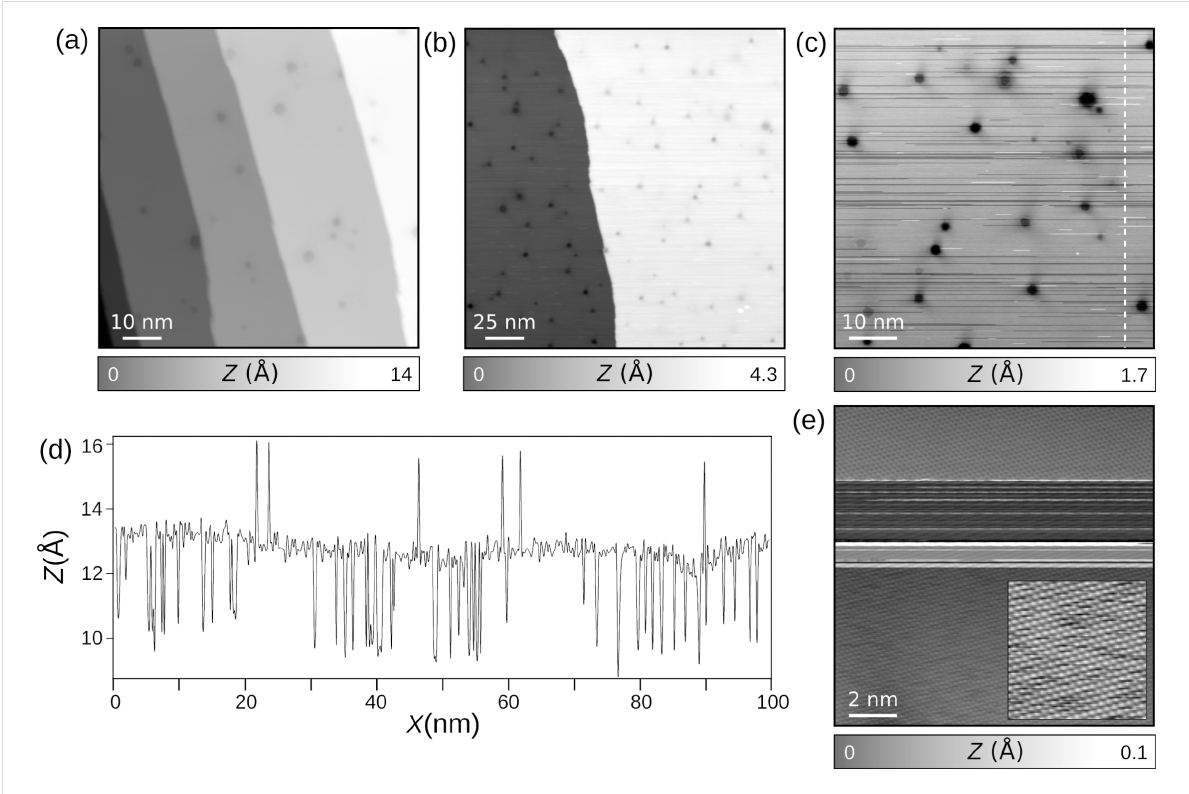
Figure 1: Carbon monoxide (CO) molecules adsorbed on Pb(111). (a) STM overview image of pristine Pb(111) ( V t = − 0.1 V, I t = 1 pA). (b) STM image after CO deposition. The estimated coverage is below 0.2 monolayers. (c) Close-up STM topography of CO molecules diffusing on the surface during scanning ( V t = − 0.1 V, I t = 40 pA). (d) Profile taken along the dashed white line of panel (c) showing spontaneous CO displacement under tip action. (e) Enhanced STM resolution (inset: more detailed image of the Pb(111) surface) resulting from the termination of the tip by a CO molecule ( V t = − 0.2 V, I t = 1